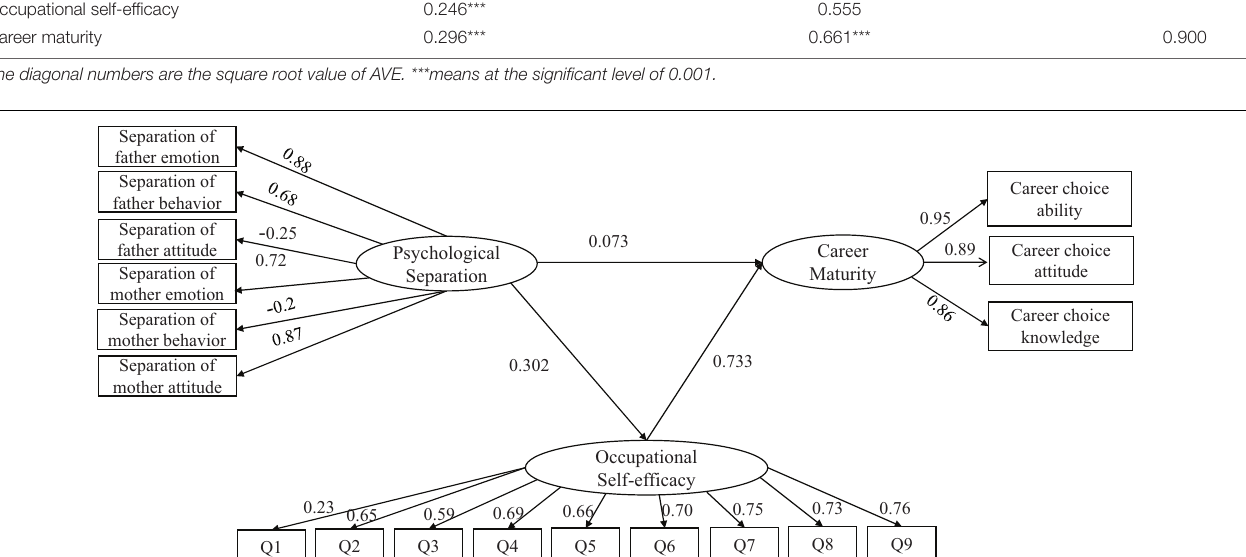
indicating that each latent variable can be well represented by its own